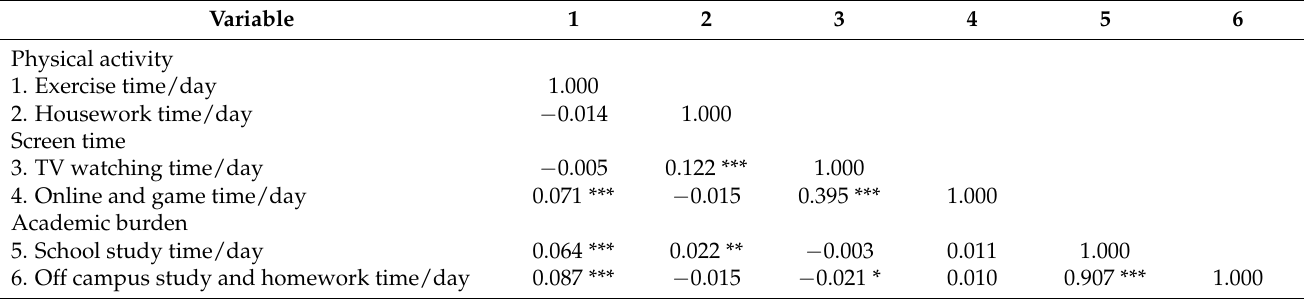
Table 2. Correlation analysis of physical activity, screen time, and academic